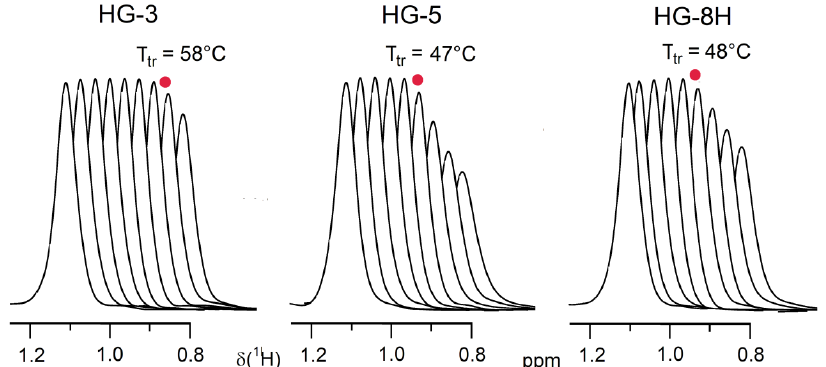
Figure 5. Temperature sensitivity for: ( a ) hydrogel HG-1 to -3, and -5 ( b ) hydrolyzed hydrogels HG- 6H to -9H at pH 5.7.